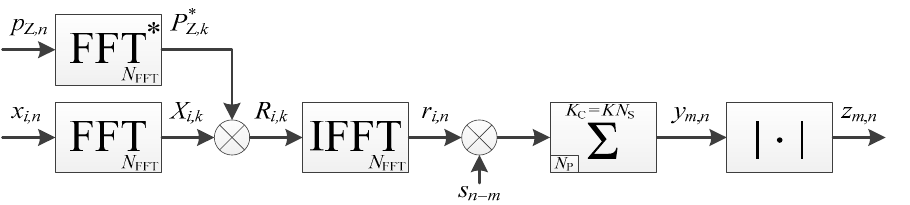
8 of 28 Figure 5. Timing diagram of the pilot channel acquisition shown in Figure 4, with (cid:1840) (cid:2903) = 4 for the illustration. 3.2.2. Coherent Integration Only with Serial Implementation The serial implementation is already given in Reference [23], and shown in Figure 6, with its corresponding timing diagram in Figure 7. However, the timing diagram in Reference [23] is not totally correct because it shows that the coherent integration for different secondary code delay is computed first and then non-coherent accumulations can be done, which is not correct or would require additional storage. In Figure 7, the correlations and further coherent accumulations are computed first, and then the operation is repeated for different delays of the secondary code. Note, however, that the processing time in Reference [23] is correct and identical to the one given below. The processing time for one frequency bin is thus, (cid:1846) (cid:2890)(cid:2886) = (cid:1837)(cid:1840) (cid:2890)(cid:2890)(cid:2904) (cid:1840) (cid:2903)(cid:2870) + 2((cid:1840) (cid:2890)(cid:2890)(cid:2904) + (cid:1838)) − ((cid:1840) (cid:2900) + (cid:1840) (cid:2910) ) = (cid:1837)(cid:1840) (cid:2903)(cid:2870) (2(cid:1840) (cid:2900) + (cid:1840) (cid:2910) ) + 3(cid:1840) (cid:2900) + (cid:1840) (cid:2910) + 2(cid:1838) = (cid:1840) (cid:2900) (2(cid:1837)(cid:1840) (cid:2903)(cid:2870) + 3) + (cid:1840) (cid:2910) ((cid:1837)(cid:1840) (cid:2903)(cid:2870) + 1) + 2(cid:1838).